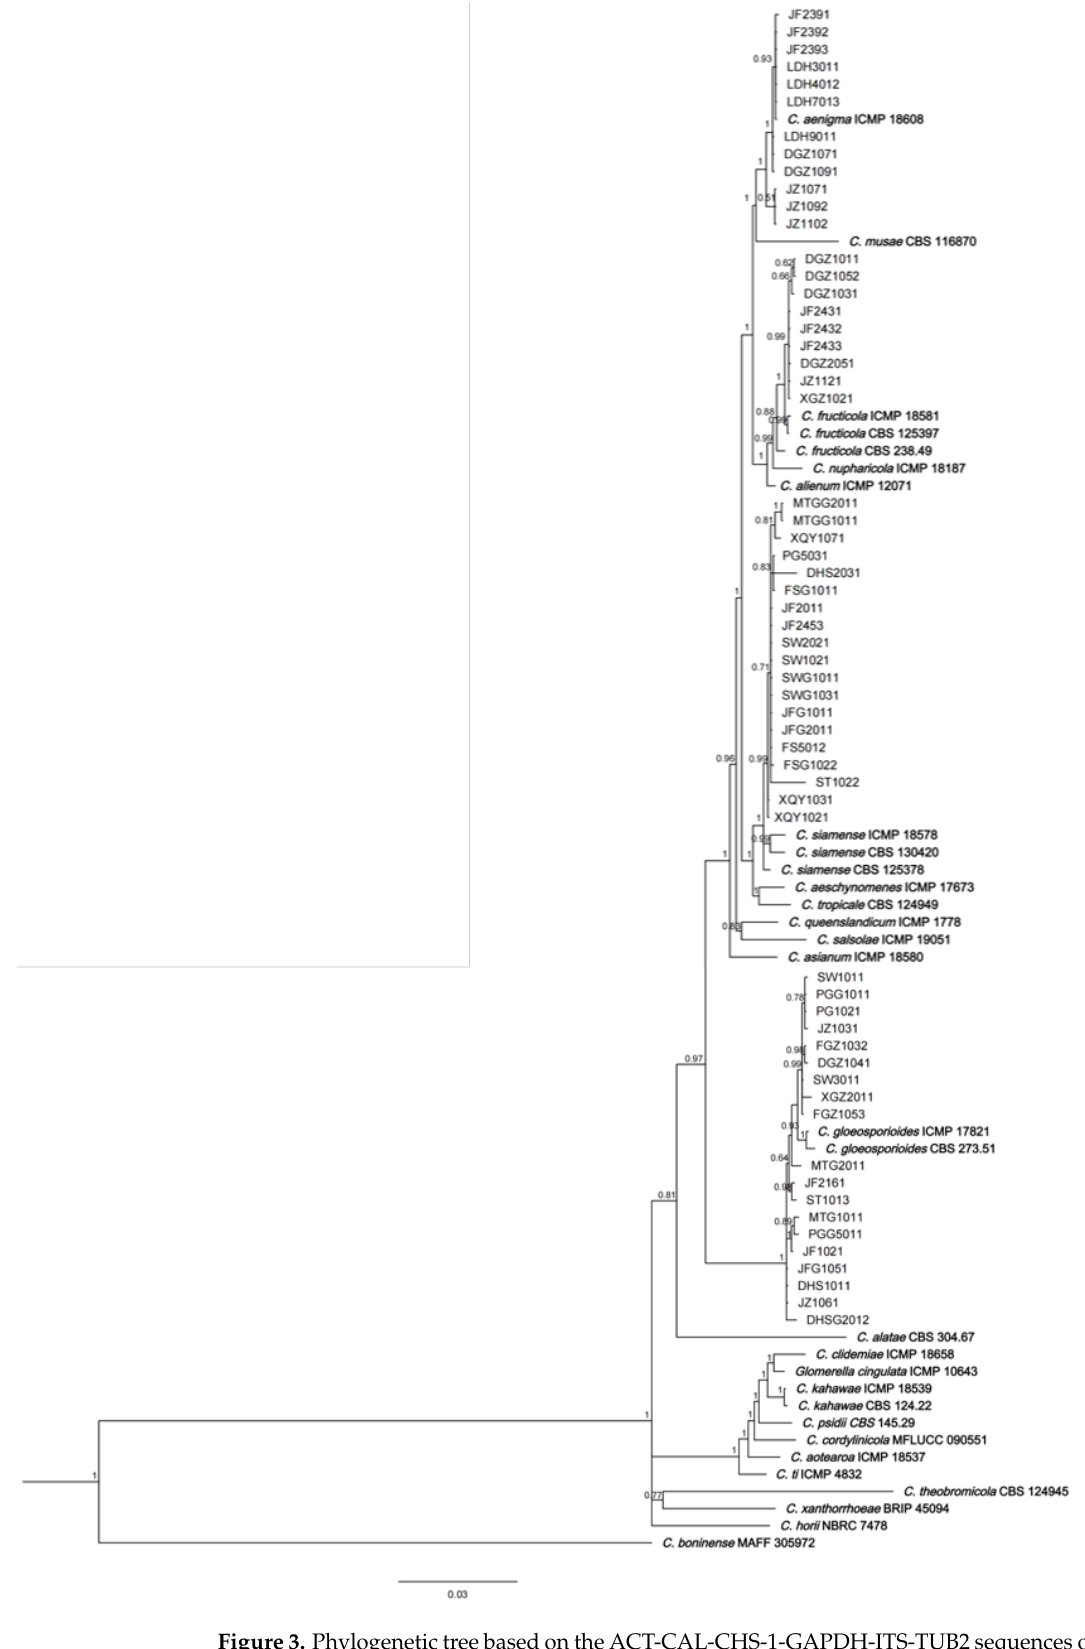
Figure 3. Phylogenetic tree based on the ACT-CAL-CHS-1-GAPDH-ITS-TUB2 sequences of 59 isolates and 30 model strains of the C. gloeosporioides species complex. Model strains are shown in bold. The scale bar shows a change of 0.03 for each site. Using the same approach as above, another Bayesian phylogenetic tree was constructed for the isolated C. magnum and C. orchidearum species complex, along with